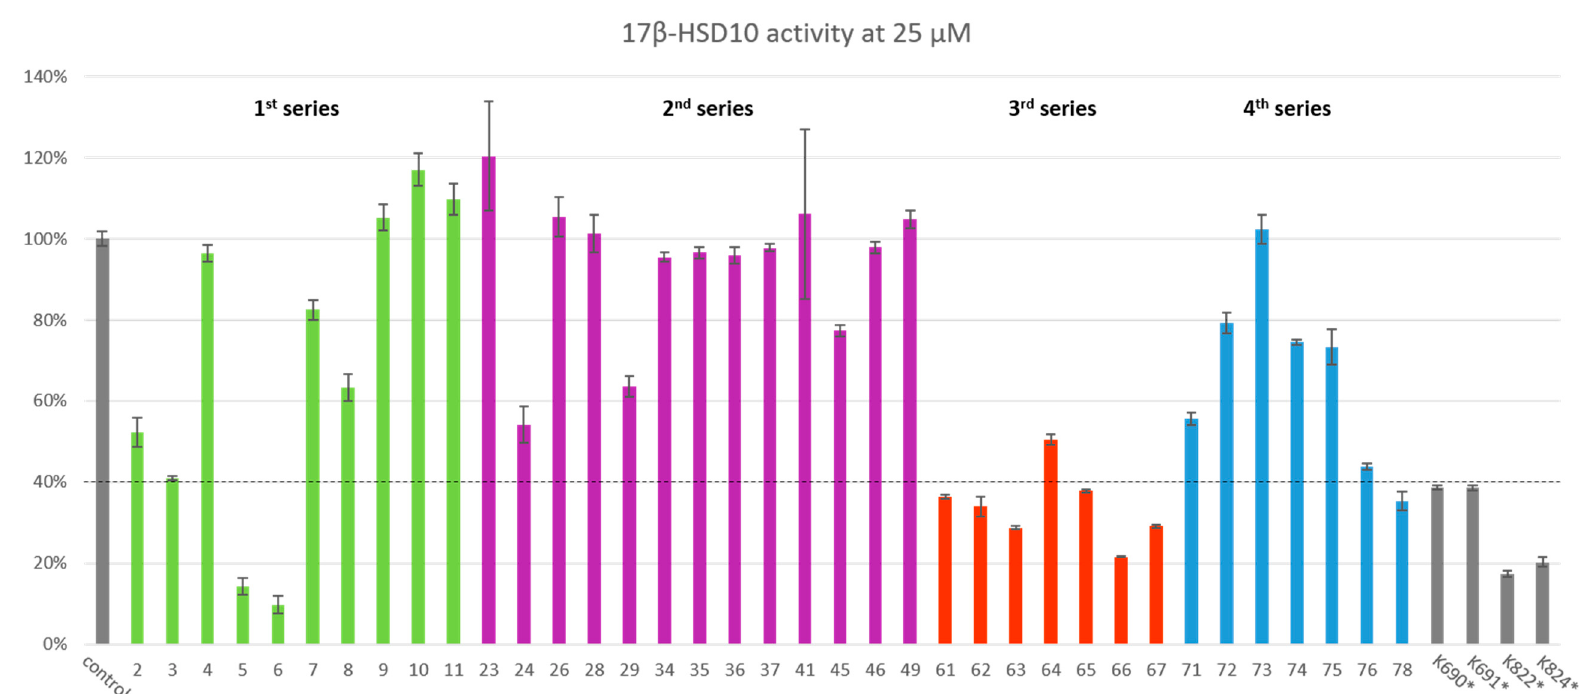
Figure 4. Primary compound in vitro evaluation (relative remaining activity at 25 µ M inhibitor concentration is displayed in percentage of six independent measurements ± SEM; detailed results in Supplementary data). * Authors’ previously published most potent enzymatic data from Hroch et al. 2016 (Design, synthesis and in vitro evaluation of benzothiazole-based ureas as potential ABAD / 17 β -HSD10 modulators for Alzheimer’s disease treatment)